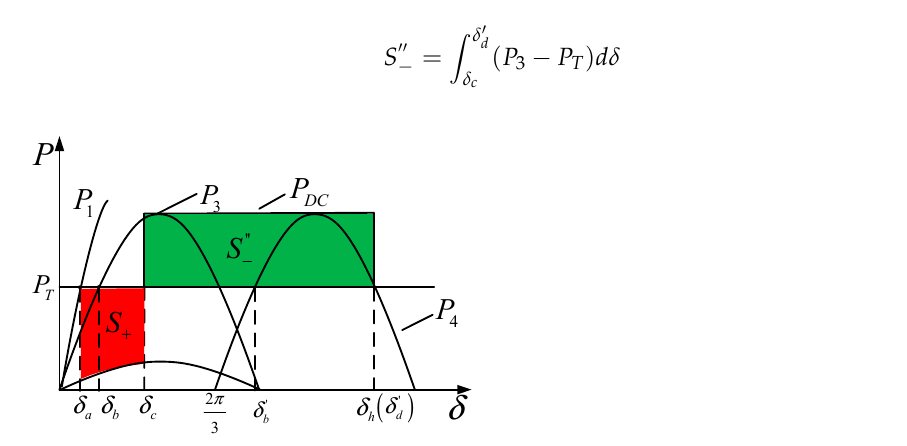
Figure 5. Power angle characteristic curve before and after phase sequence changing based on a MMC.